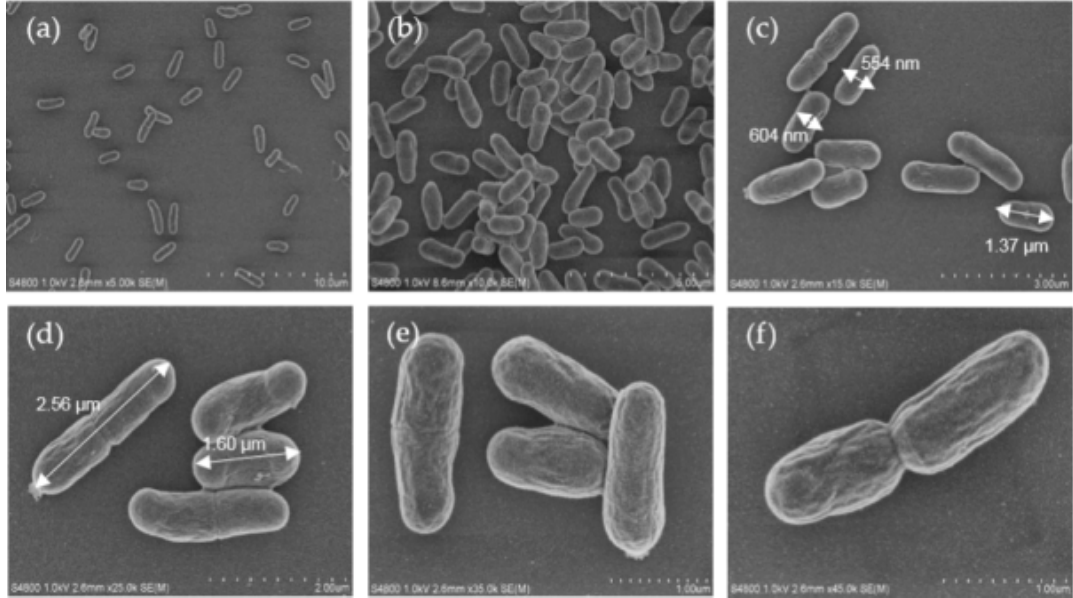
Figure 1. Scanning electron microscopic (SEM) images of oraCMU at various magnifications: 5000× ( a ), 10,000× ( b ), 15,000× ( c ), 25,000× ( d ), 35,000× ( e ), and 45,000× ( f ).